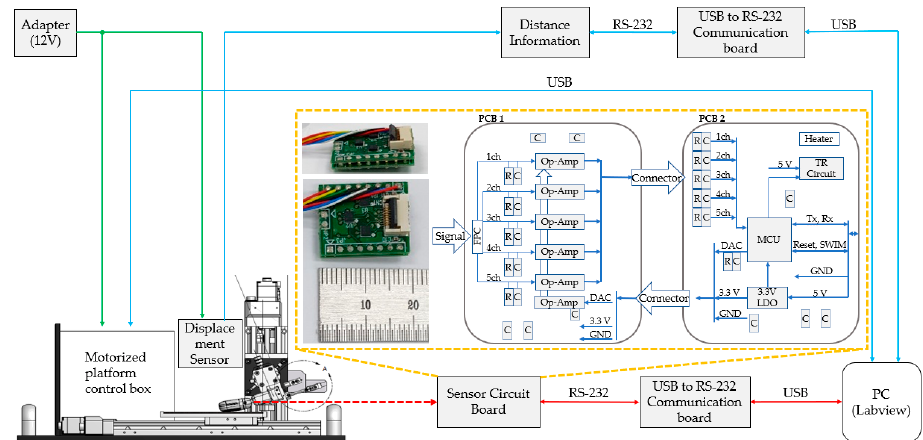
Figure 2. Photo showing the experiment of measuring a hard sponge (# 12) sample with a motorized texture discrimination platform equipped with a robot fingertip module.